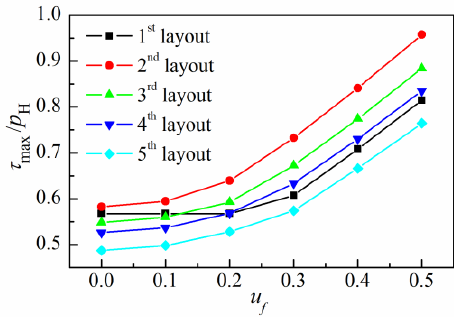
Figure 6. Influence of the structure layout of multilayered solids on the peak value of the maximum shear stress in the subsurface under various friction coefficients.